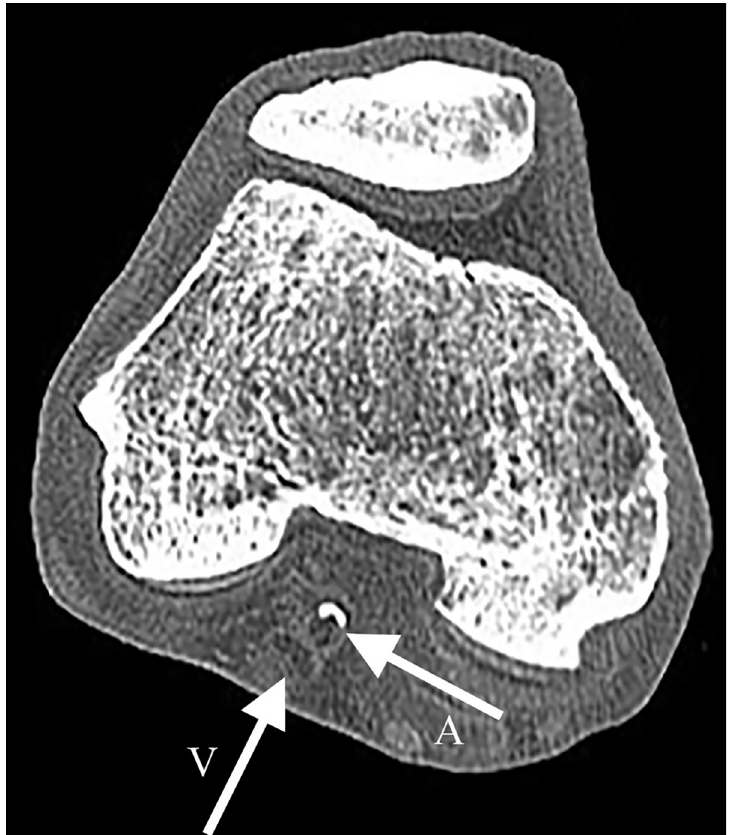
Fig 3. Unenhanced CT of frozen lower extremity of a human cadaver. The vein and artery are indicated with an arrow with ‘A’ and ‘V’ respectively. Differentiation between arterial lumen, vascular wall and calcifications are possible.